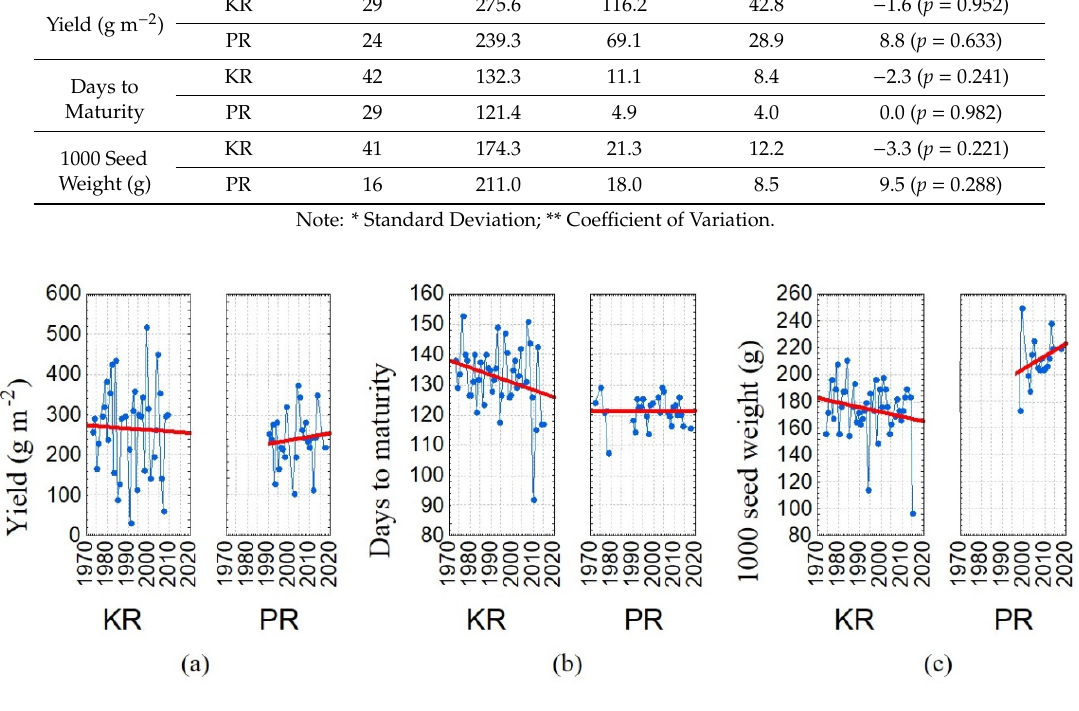
Figure 4. Dynamics of the characteristics of the soybean standard varieties in KR and PR: ( a ) crop yield; ( b ) number of days from emergence to maturity; ( c ) 1000 seed weight. Red line—the linear trend. Productivity in PR positively correlates with the summer temperatures in June (r = 0.48, p = 0.048), in August (r = 0.51, p = 0.007), and with May rainfall (r = 0.60, p = 0.003). A negative correlation Table 2. Year-to-year variation in the characteristics of the soybean standard varieties in KR and PR. was found to exist with precipitation in June (r = − 0.48, p = 0.036) and August (r = − 0.48, p = Parameter Location